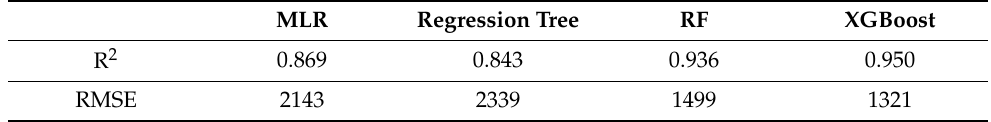
Table 5. Comparison of model performance on the test dataset.